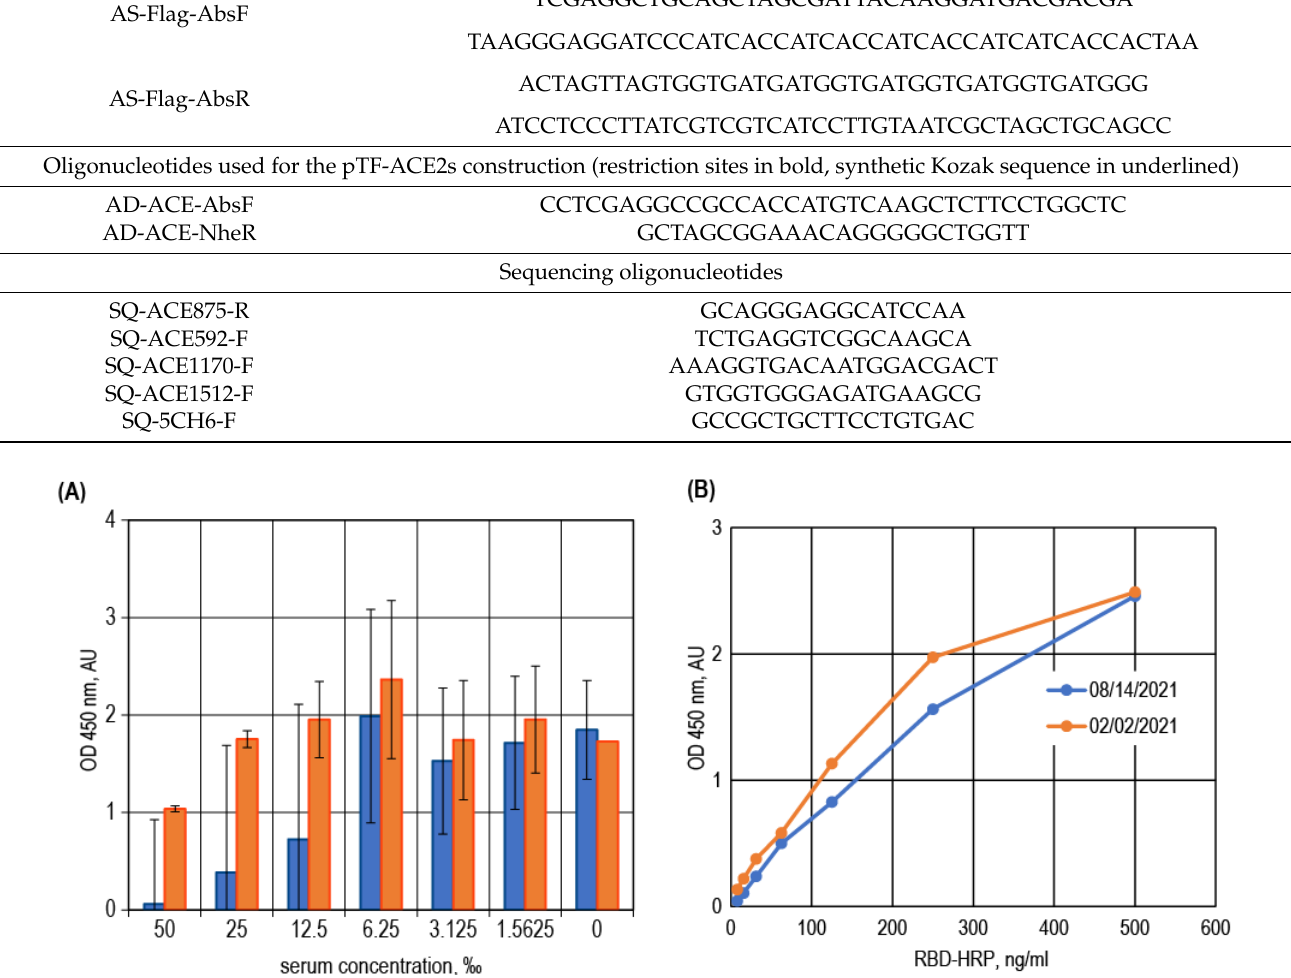
Table A1. Oligonucleotides used for cloning and sequencing